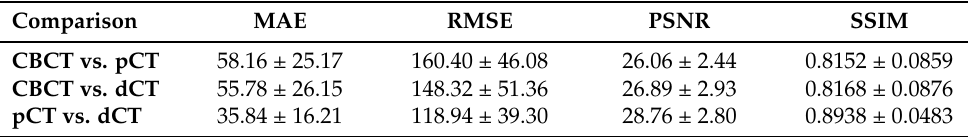
Table 2. Comparison of CBCT, pCT, and dCT using different similarity metrics.